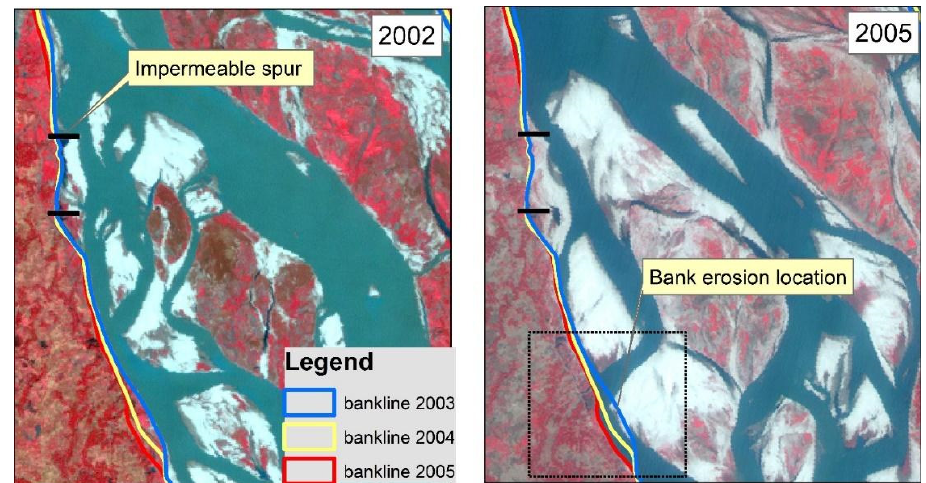
Figure 22. Bank erosion downstream of the impermeable spur at Brahmaputra–Jamuna (location: Dhunot, Bogra, Bangladesh).